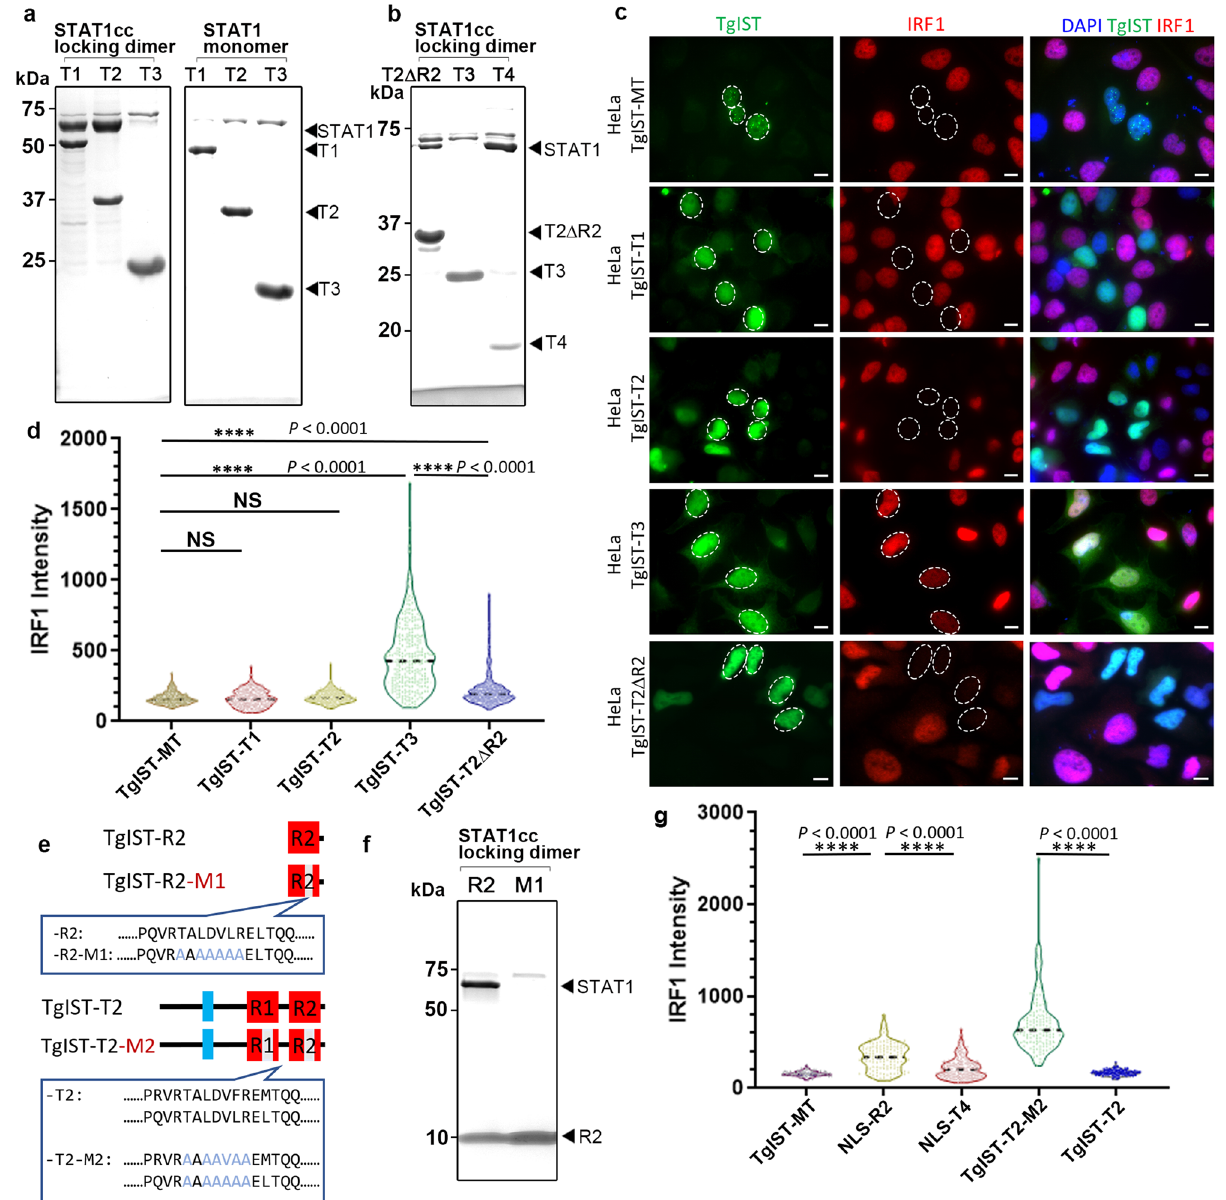
Fig. 2 The TgIST repeats are required for STAT1 dimer binding and inhibition of IFN- γ signaling in host cells. a , b Co-puri fi cation of STAT1cc or STAT1 with TgIST constructs as de fi ned in Fig. 1d following co-expression in E. coli . Co-puri fi cations were performed by capturing TgIST His 6 -tagged constructs with nickel resin. SDS-PAGE gels stained with Coomassie blue. Representative gel images of two independent experiments with similar results are shown here. c Representative images showing induction of IRF1 in transfected Hela cells. Cells transiently expressing GFP-tagged TgIST constructs for 24 h were activated with IFN- γ for 6 h followed by staining for GFP (green), IRF1 (red) and DAPI (blue). Scale bar = 10 μ m. Expression level of STAT1 remained unchanged (see Supplementary Fig. 3). Representative micrographs of two independent experiments with similar results are shown here. d Distribution of the IRF1 intensity collected from at least 250 TgIST-expressing HeLa. **** P ≤ 0.0001 with Kruskal – Wallis ’ s test for multiple comparisons, and with Dunn ’ s test for non-parametric correction. TgIST constructs correspond to those shown in ( c ) and are listed only with the suf fi x denting the construct. Data presented as violin plot and median (dotted line) from two independent experiments are shown. e Sequences of wild type TgIST-R2 containing a single repeat and a mutated version with an altered core region de fi ned by changing TALDVLR to AAAAAAA (TgIST-R2-M1). Sequences of wild type TgIST-T2 containing two repeats and a mutated version with an altered core region de fi ned by changing TALDVLR to AAAAAAA (TgIST-T2-M2). ( f ) TgIST-R2 and TgIST-R2-M1 tagged with His 6 were co-expressed with the STAT1cc locked dimer. Puri fi cation of the His-tagged TgIST proteins on nickel resin resulted in co-puri fi cation of STAT1cc with the wild-type TgIST-R2 (R2) construct but not the R2-M1 mutant (M1). SDS-PAGE gel stained with Coomassie blue. Representative gel image of two independent experiments with similar results are shown here. g The core repeat region was required for blocking IFN- γ signaling as detected by induction of IRF1. IRF1 intensity levels of HeLa cells stained as above. Data were collected from at least 250 TgIST-expressing (NLS-R2 or NLS-T4: R2 or T4 protein with nuclear localization sequence) HeLa cells and expressed as violin plots. **** P ≤ 0.0001 with Kruskal – Wallis ’ s test for multiple comparisons, and with Dunn ’ s test for non-parametric correction. Data presented as median (dotted line) from two independent experiments. Source data are provided in the Source Data fi